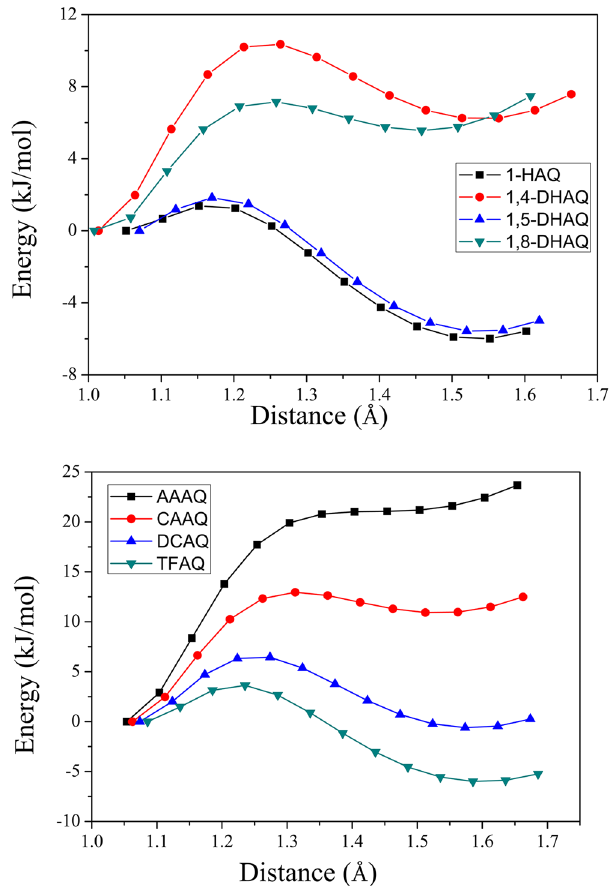
Figure 4. The scan of PES of S 1 state of eight compounds as a function of O D (N D )–H bond length. The energy of stable structure in S 1 state after structure optimization is set as zero